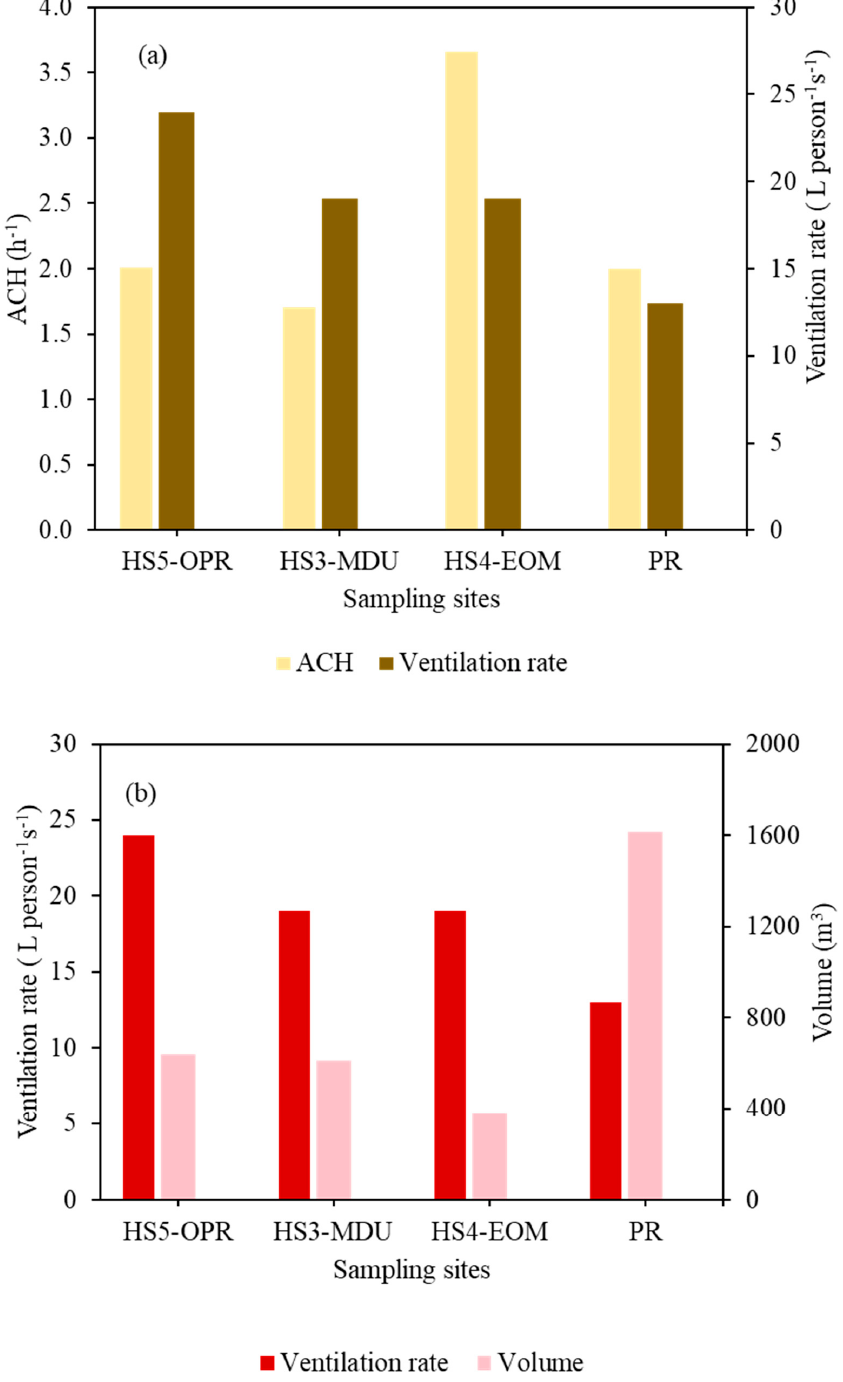
Figure 6. ( a ) Mean ACH values for mechanically ventilated indoor environments against ventilation rate per person for HS5-OPR, HS3-MDU, HS4-EOM and PR. ( b ) Ventilation rate plotted against volume in indoor environments (HS5-OPR, HS3-MDU, HS4-EOM, PR) to show the influence of the room volume on ventilation rate per person.